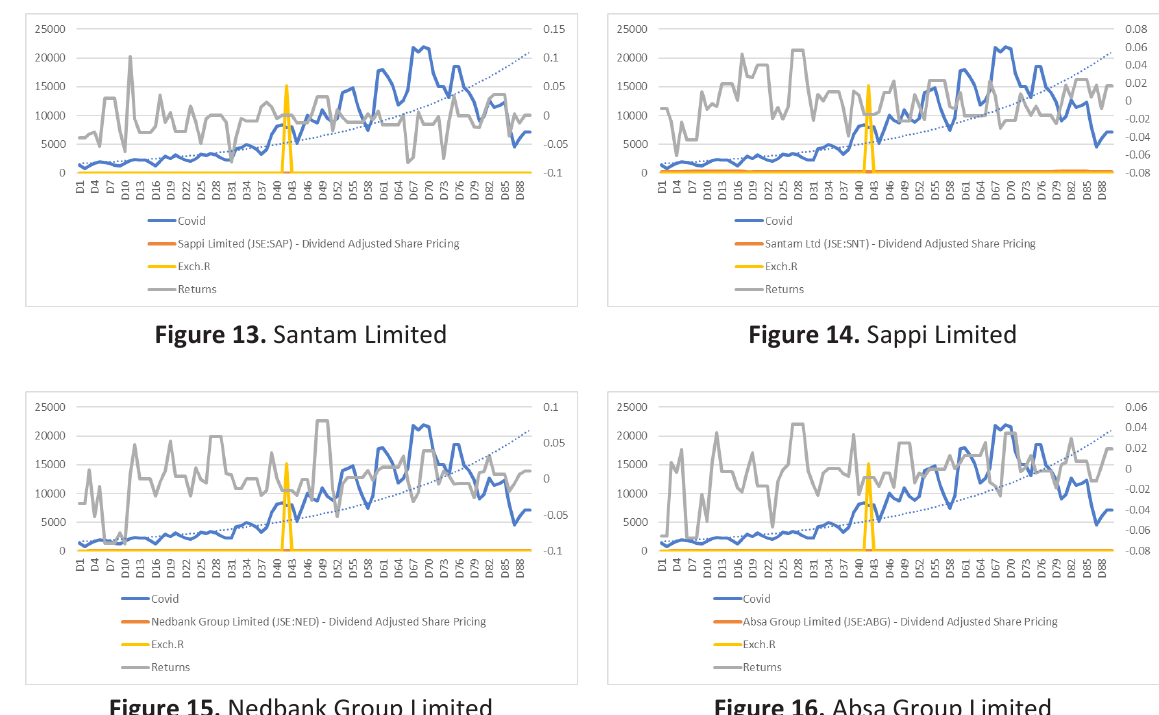
Figure 15. Nedbank Group Limited Figure 16. Absa Group Limited